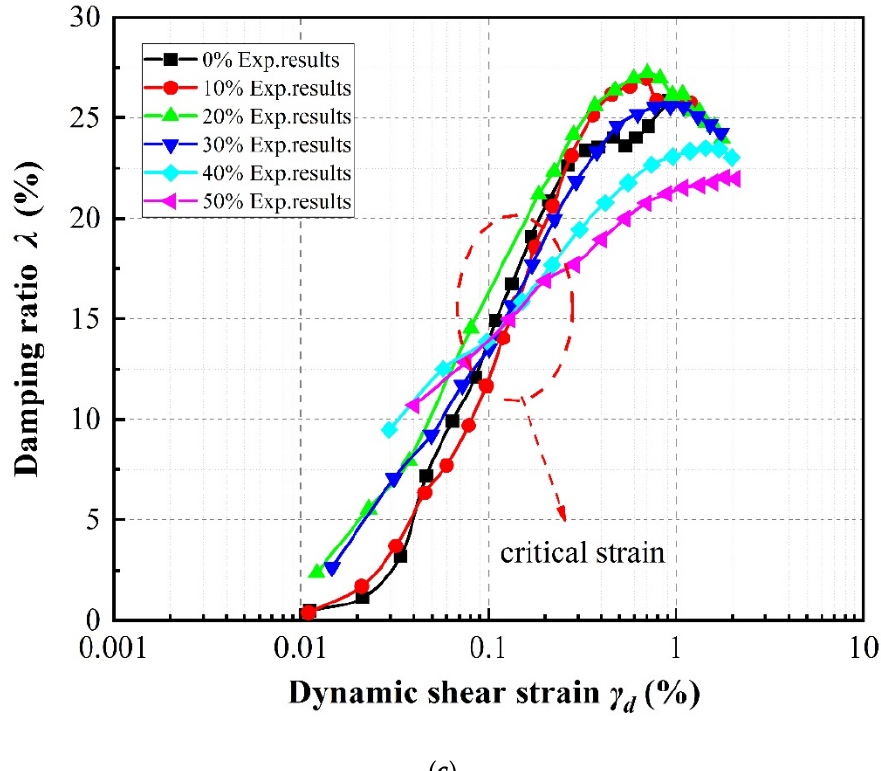
Figure 12. Effect of rubber content on damping ratios of SRP2 sand–rubber mixtures under confining pressures of: ( a ) 50 kPa; ( b ) 100 kPa; ( c ) 150 kPa.